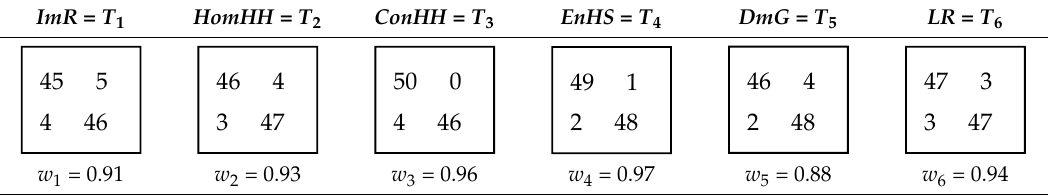
Table 5. The confusion matrices and the resulting weights for the selected features.